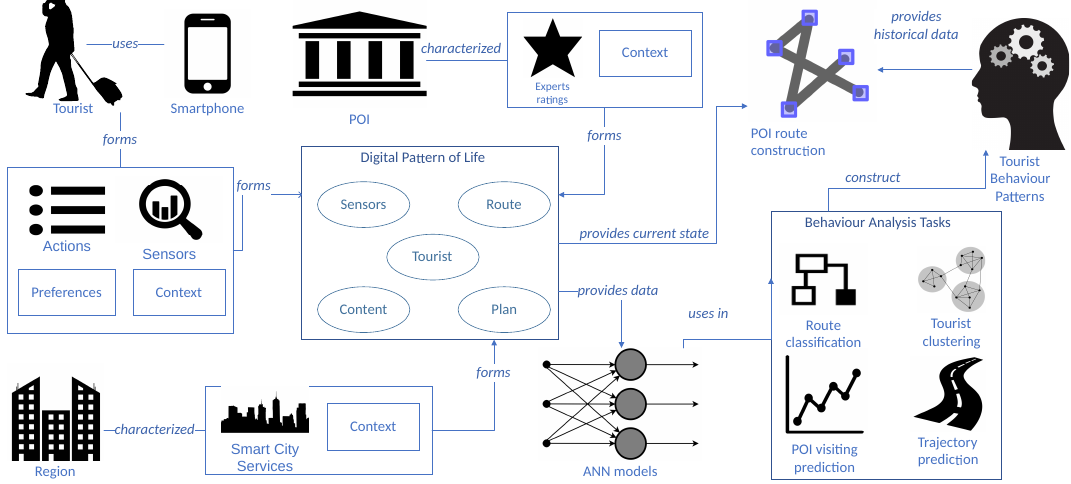
Figure 1. Tourist support system reference